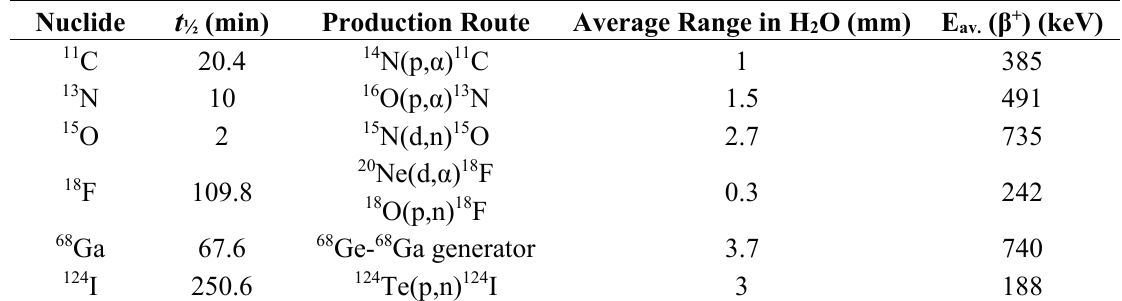
Table 1. Most commonly used PET radionuclides with their radiochemical details [3].